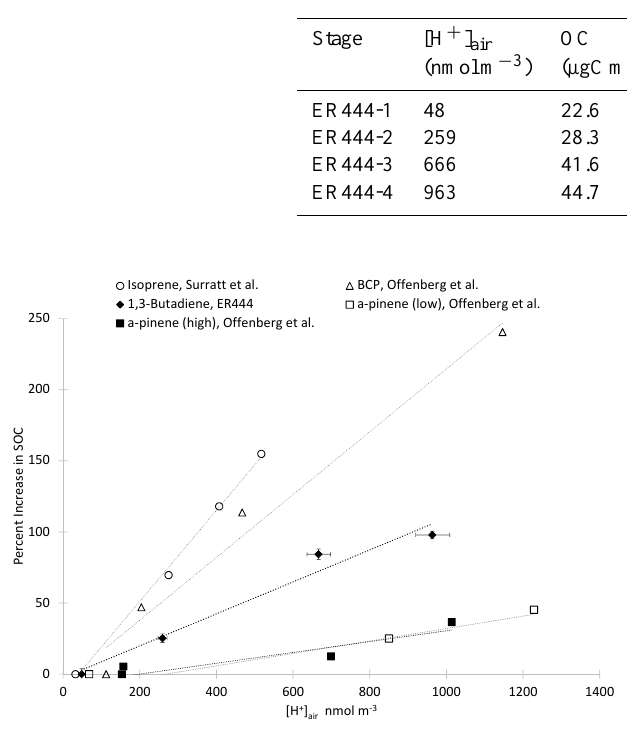
Figure 2. Aerosol acidity effect for 1,3-butadiene/NO, relative to previously published data (Surratt et al., 2007; Offenberg et al., 2009). All experiments were conducted with nebulized sulfate aerosol at 30% relative